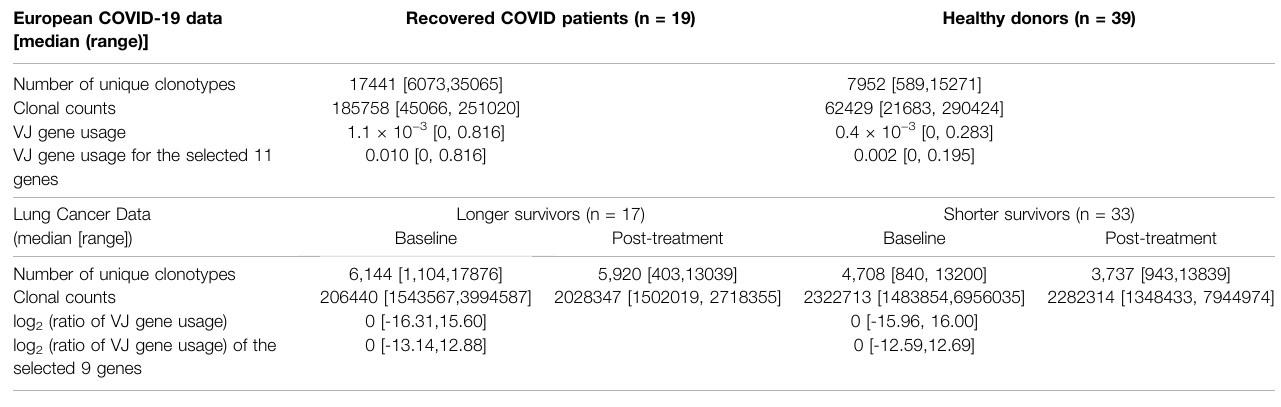
TABLE 1 | Summary of TCR sequences in the real datasets.